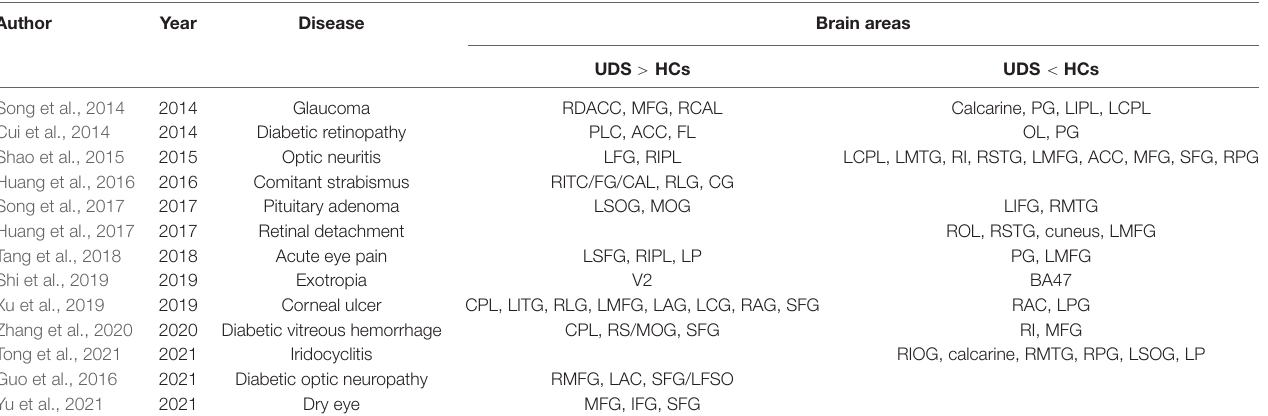
TABLE 1 | ReHo method applied in ophthalmological diseases (partially).